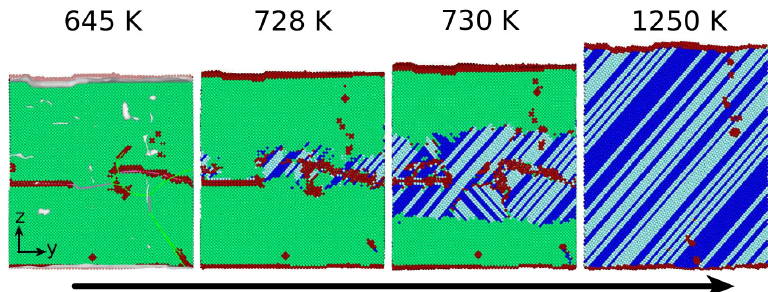
Figure 3. Snapshots of a dislocation-free bcc sample before, during, and after the austenitic transformation at temperatures of 10, 919, and 1250 K, respectively. The colors denote the local lattice structure as in Figure 1.